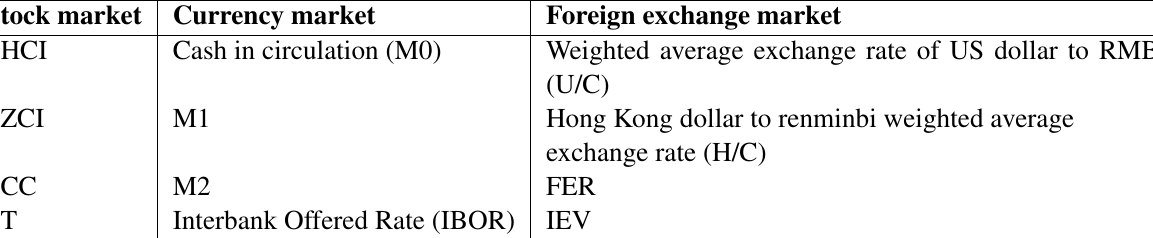
Table 2 12 decision-making indicators selected.